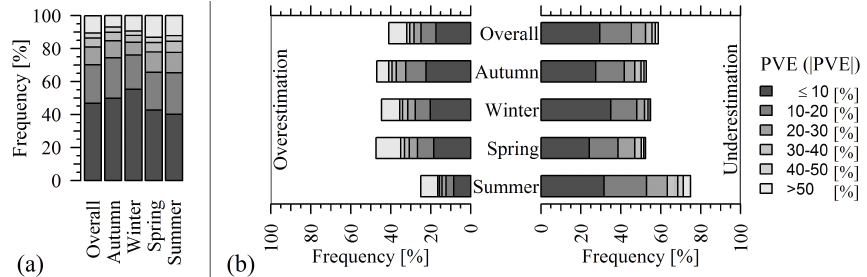
Figure 5. Stacked-column plots of (a) PVE counts of the six absolute PVE classes ( ≤ 10, 10–20, 20–30, 30–40, 40–50 and > 50%) observed in reservoir inflow forecasts from the complementary set-up, and (b) the corresponding fraction of times under- and overestimation incidents corresponding to the six PVE classes occurred. Hydrologic years